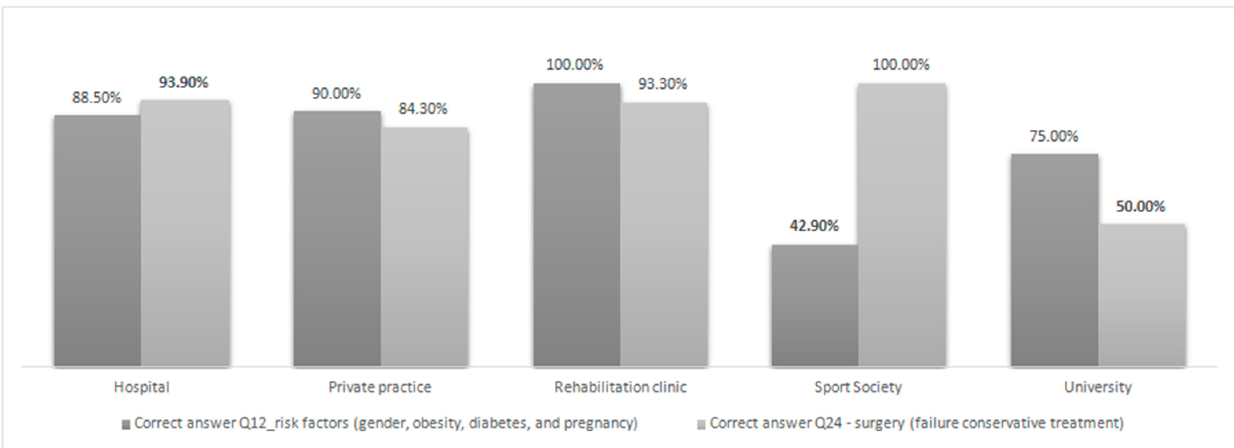
Figure 4. Inferences between places of professional activity and correct answers (Q12 and Q24). Acronyms: Q, question. Bold values outside the box are the ones with statistical significance in the residual p -values. Tabled as percentage of respondent ( n = 508).